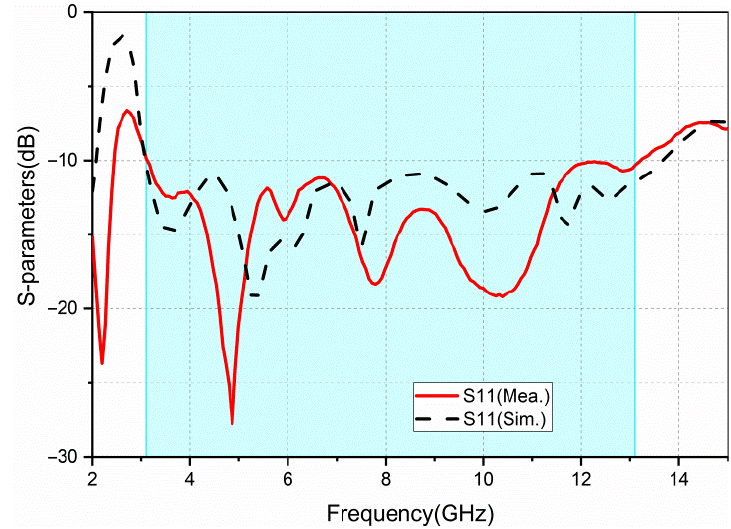
( b ) Figure 7. Photograph of the fabricated antenna: ( a ) top; ( b ) bottom. 3.1. S-Parameters